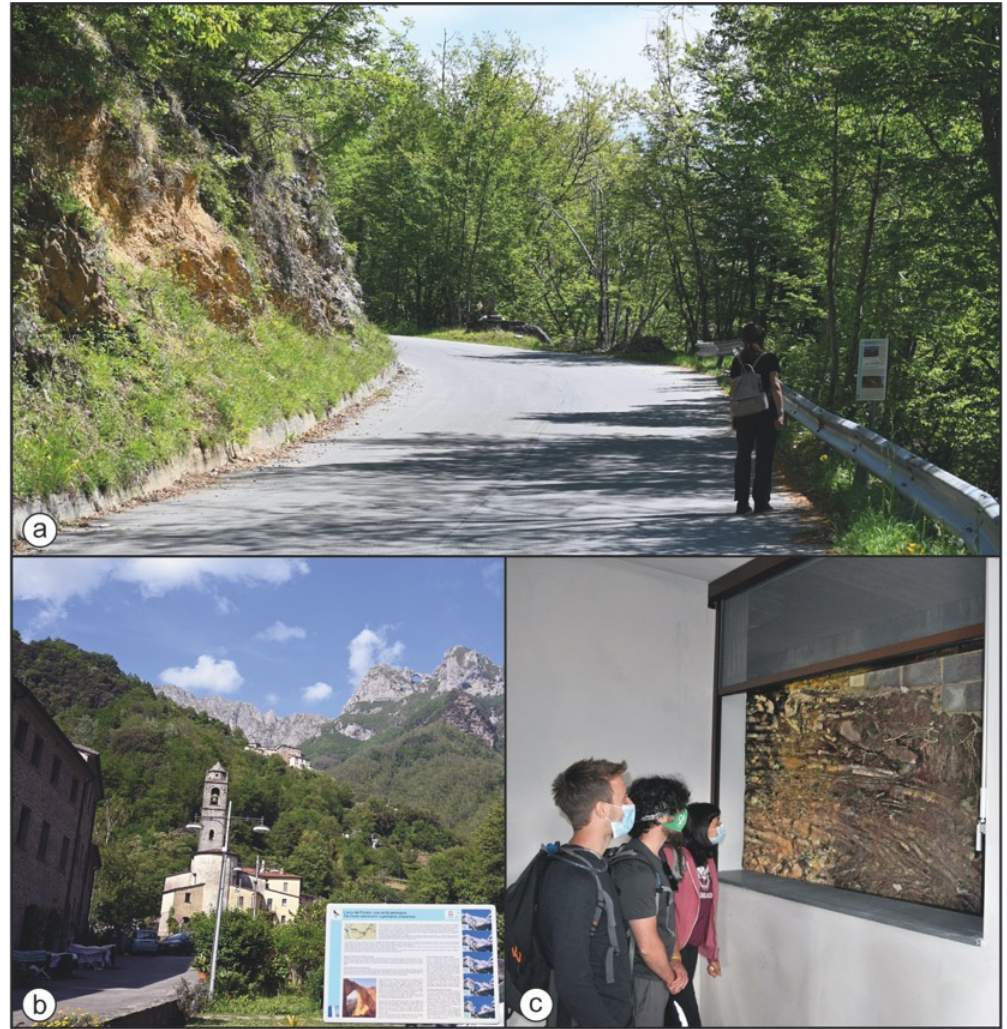
Figure 8. Pictures of the three new panels of the structural geosites presented in this contribution (see Supplementary material to see the interpretative panels). ( a ) The panel of the Apuan Alps tectonic windows geosite located in front of the roadcut outcrop along the road from Capanne di Careggine to Careggine (GPS coordinates: 44°05 ′ 44.4 ″ N 10°19 ′ 28.4 ″ E); ( b ) the Mt. Forato Arch geosite and the related panel view from the parking lot in the village of Cardoso (GPS coordinates 44°00 ′ 25.2 ″ N 10°18 ′ 54.6 ″ E); ( c ) Students looking the folds of Bosa geosite through the suggestive window that was appositely left opened during the building of the cellar of the Apuan Alps UGGp farm in Bosa (Careggine) (GPS coordinates 44°07 ′ 19.9 ″ N 10°19 ′ 10.4 ″ E).